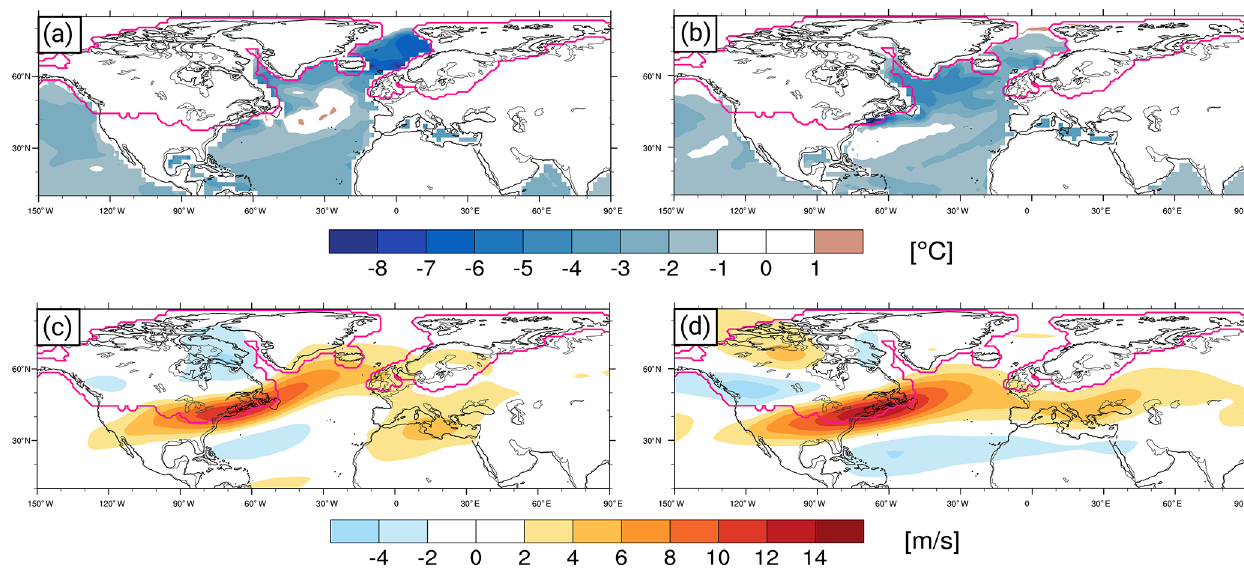
Figure 2. (a) Distribution of annual mean SST differences between the global MPI simulations under LGM and PI conditions. Panel (b) is the same as panel (a) but for the global AWI simulations. Panels (c) and (d) are the same as panels (a) and (b) but for the annual mean wind speed at